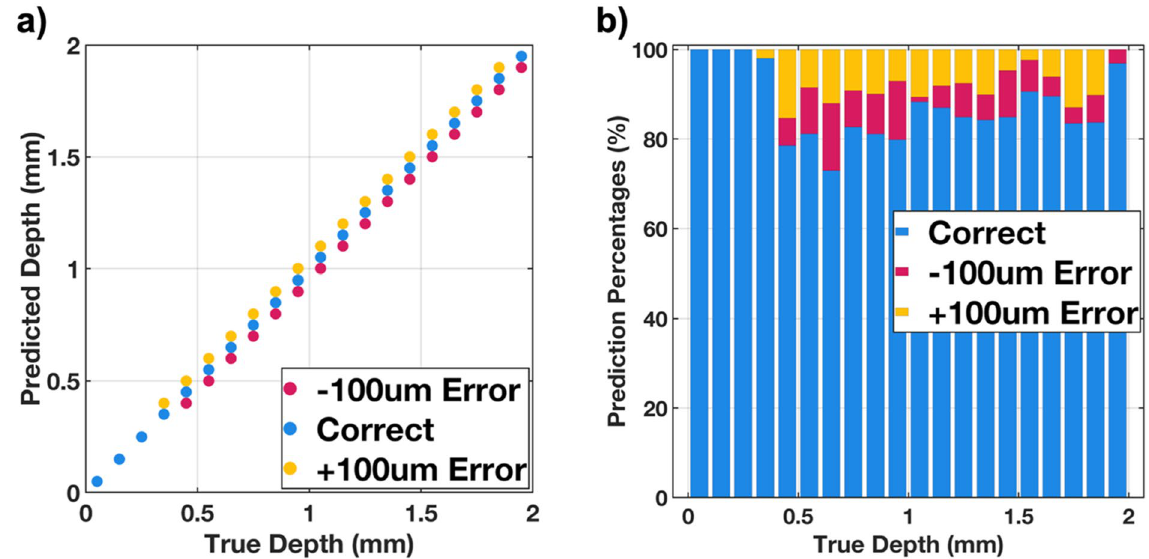
Figure 2. Performance of the depth estimator module: ( a ) Predicted values for every depth in the test dataset. ( b ) Test accuracy and loss for depths ranging from 50 µm to 1.95 mm with 100 µm step sizes.